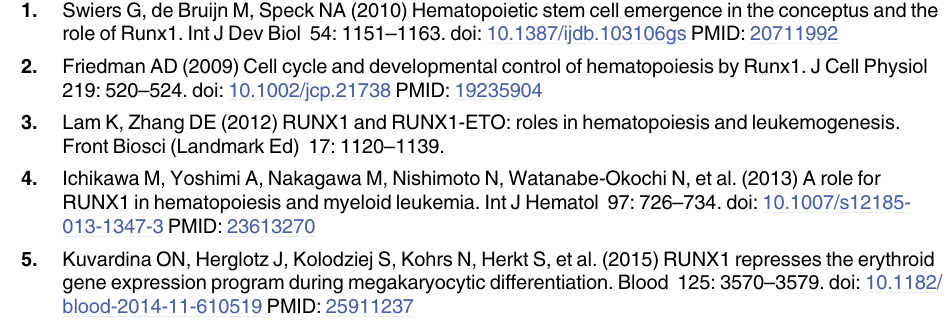
surface marker GYPA and CD71 increase as shown by FACS. (C) Megakaryocytic differentia- tion of hCD34+ cells. Cells were expanded for 3 days and megakaryocytic differentiation was induced. Shown is the increase of the megakaryocytic surface marker CD61 as measured by FACS. S8 Fig. (A) Screen shot of the genomic region of miR144/451 (altered). The miR144 and miR451 coding regions are highly conserved. The genomic region, which was cloned into a len- tiviral expression vector (compare Fig 4) is marked. (B) Expression validation of the miR144/ 451 constructK562 cells were transfected with the miR144/451 pri-microRNA expression vec- tor. Expression of the mature microRNAs miR144 and miR451 was determined using Taq- man q-RT-PCR. (C) The cloned miR144/451 genomic region is given. The miR144 region is marked in bold, the miR451 region is marked in red. The micro-RNA coding regions, which were mutated are underlined (compare Fig 4). The grey areas are the primer regions used for cloning. S9 Fig. Influence of miR451 over-expression on its targets UBE2H, 14-3-3z and IL6R. The effect of miR451 over-expression on protein levels was determined in K562 cells. Western blot was performed using specific antibodies against the given proteins. Tubulin was used as load- ing